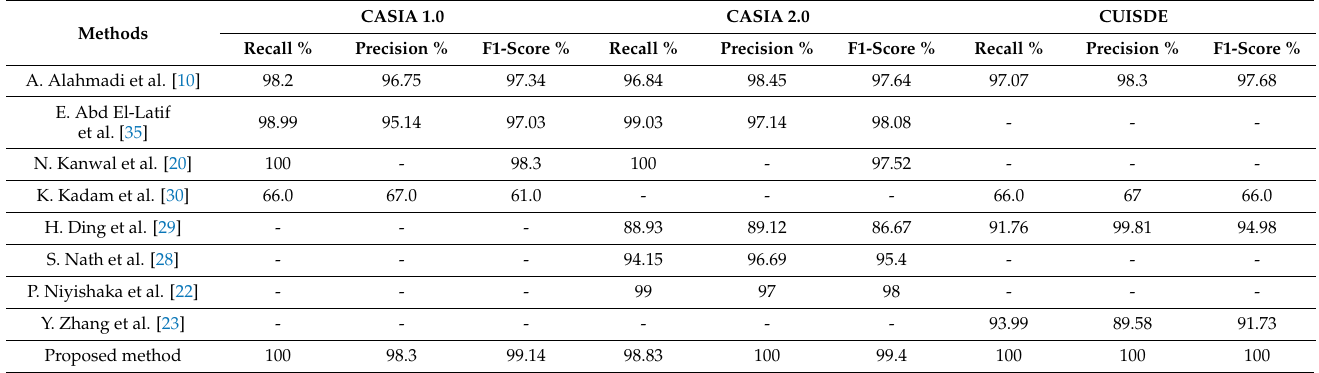
Table 5. A comparison of F1-score, precision, and recall in the case of the proposed model and other recently published approaches over the CASIA 1.0, CASIA 2.0, and CUISDE